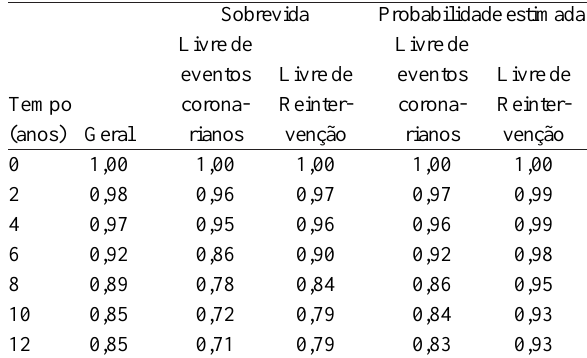
Tabela 2. Probabilidades estimada livre de eventos cardiológicos e de reintervenções, assim como a sobrevida global e livre de eventos e reintervenções. Os dados da